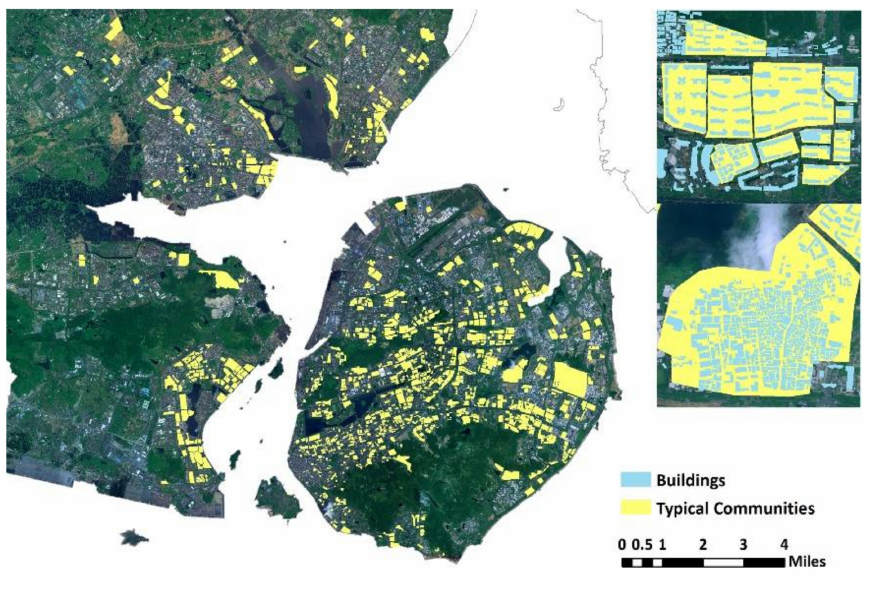
Figure 6. Distribution of typical communities and urban